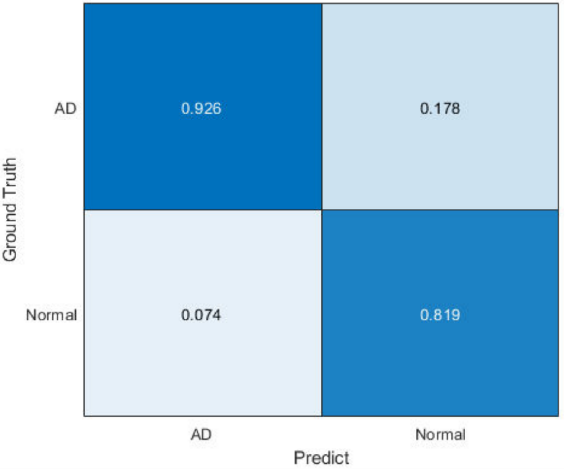
Figure 16. Confusion matrix of DeU-Net with single modality images.